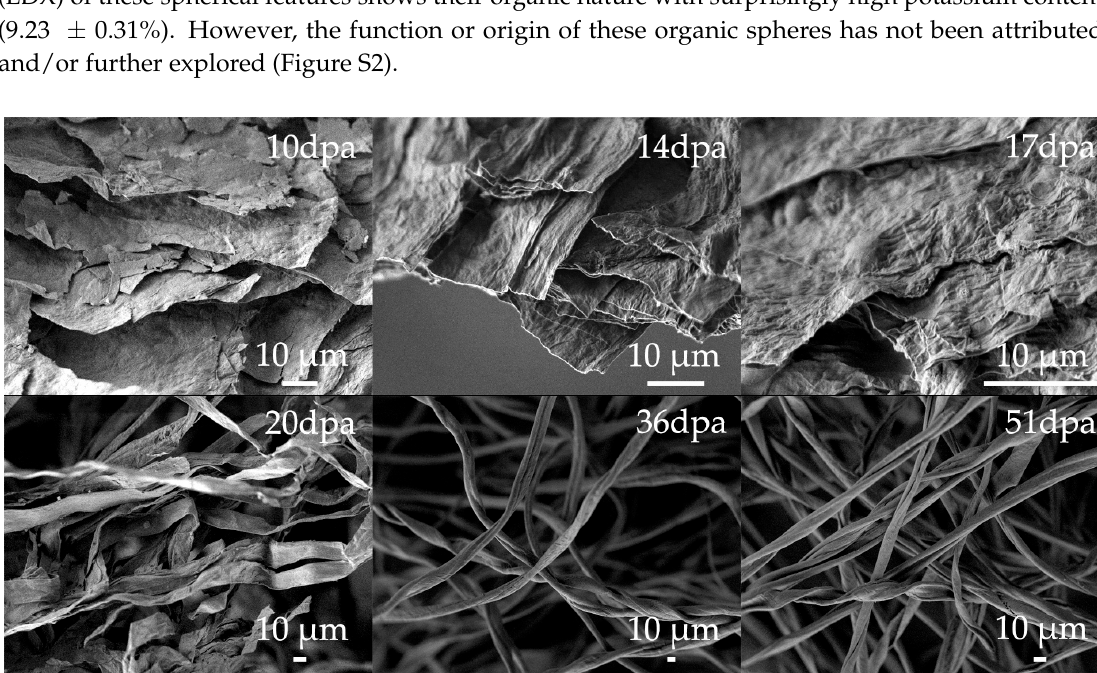
Figure 2. Scanning electron microscopic (SEM) representative images of G. hirsutum fibers grown under greenhouse and hydroponic conditions. The fibers were excised at different stages of development (from 10 until 51 dpa where full maturity is reached) without any tension or straightening and air-dried (RT). Until 17 dpa, the fibers display a flat morphology typically attributed to immature fibers. At 20 dpa, a mixture of flat fibers with slightly thicker fibers is found. No convolutions are found at this stage. The process of fiber thickening continues until 51 dpa. This process is accompanied by an increase number of convolutions and attributed to secondary cell wall growth process.